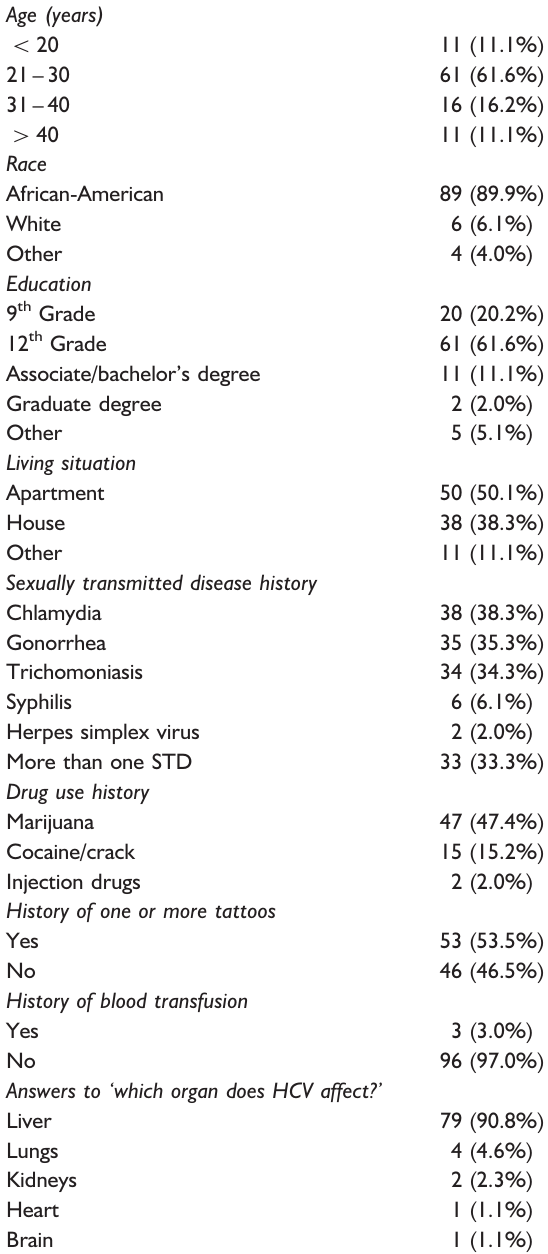
Table 1 Characteristics of 99 study